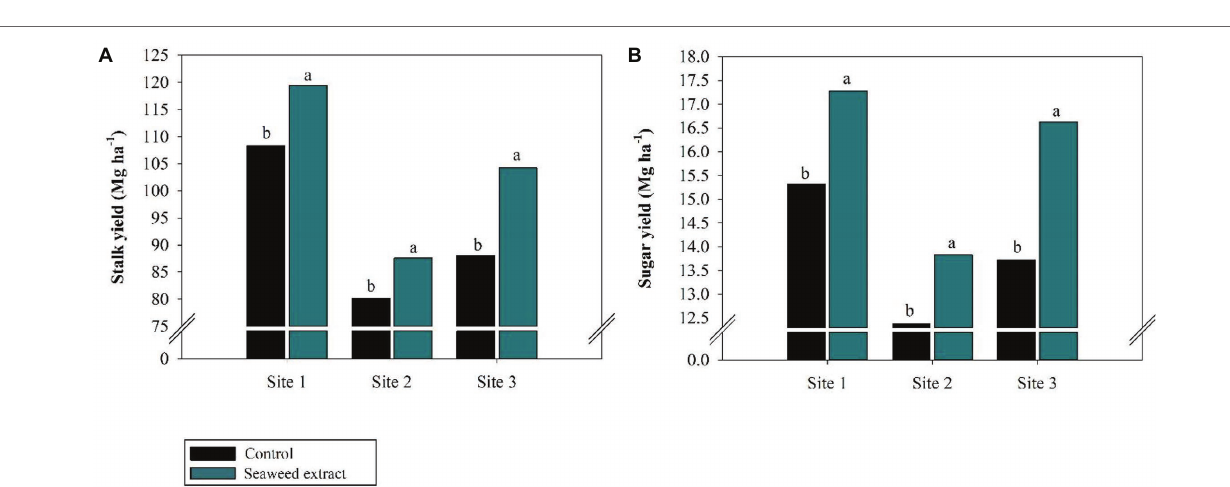
FIGURE 8 | Effects of seaweed extract (SWE) application on sugarcane yield parameters at harvest: (A) stalk yield (Mg ha − 1 ), (B) sugar Yield (Mg ha − 1 ). The treatments were as follows: Control, no SWE application; Seaweed extract: application of SWE biostimulant based on Ascophyllum nodosum in the beginning of the drought season (July at site 1 and June at sites 2 and 3). Averages followed by the same letters do not differ by the LSD test ( p <